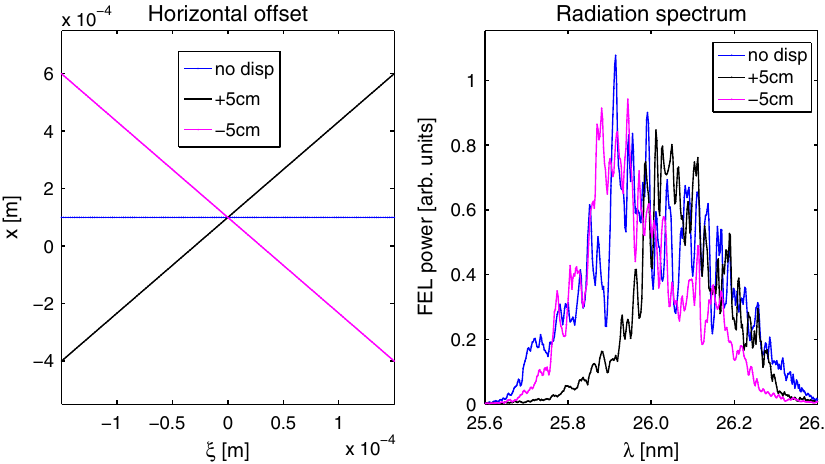
FIG. 11. (Color) Dispersion effects on the wavelength spectrum for an initial offset of 100 (cid:2) m along the bunch.